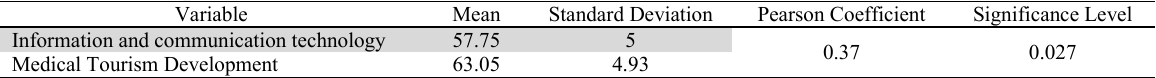
Significant Relationship Test between information and communications technology and Medical Tourism